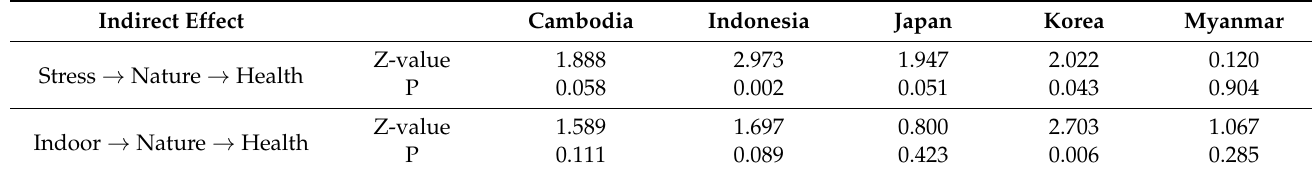
Table 7. The indirect effect in the Sobel